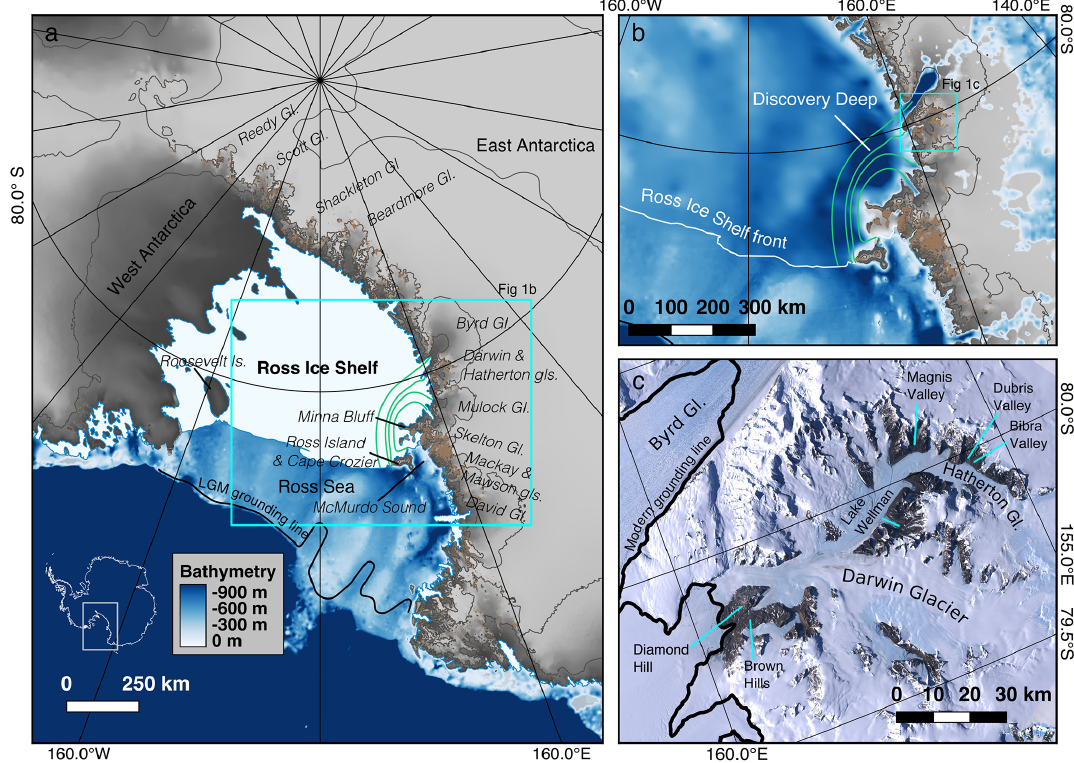
Figure 1. (a) The Ross Embayment of Antarctica, with regional and study locations noted. The modern ice sheet surface is shown in gray, the modern ice shelf is shown in white, and exposed rock is shown in brown. Bathymetry beyond the Ross Ice Shelf front is shown in blues (Fretwell et al., 2013). LGM grounding line from Halberstadt et al. (2016). Flow lines through the ice shelf from Byrd, Darwin, Mulock, and Skelton glaciers are shown in green and calculated using the software of Greene et al. (2017). (b) Inset of area outlined with cyan box in panel A, with bathymetry shown in the same color map as (a) . The Ross Ice Shelf has been removed to show bathymetry. The combined Byrd–Darwin–Mulock–Skelton flow path covers Discovery Deep, which is the deepest part of the seafloor in the Ross Embayment. (c) Landsat imagery of Darwin and Hatherton glaciers, with labels for locations mentioned in the text (Bindschadler et al., 2008). The modern grounding line is shown by the thick black line. Note the prominent blue-ice fields on the glacier